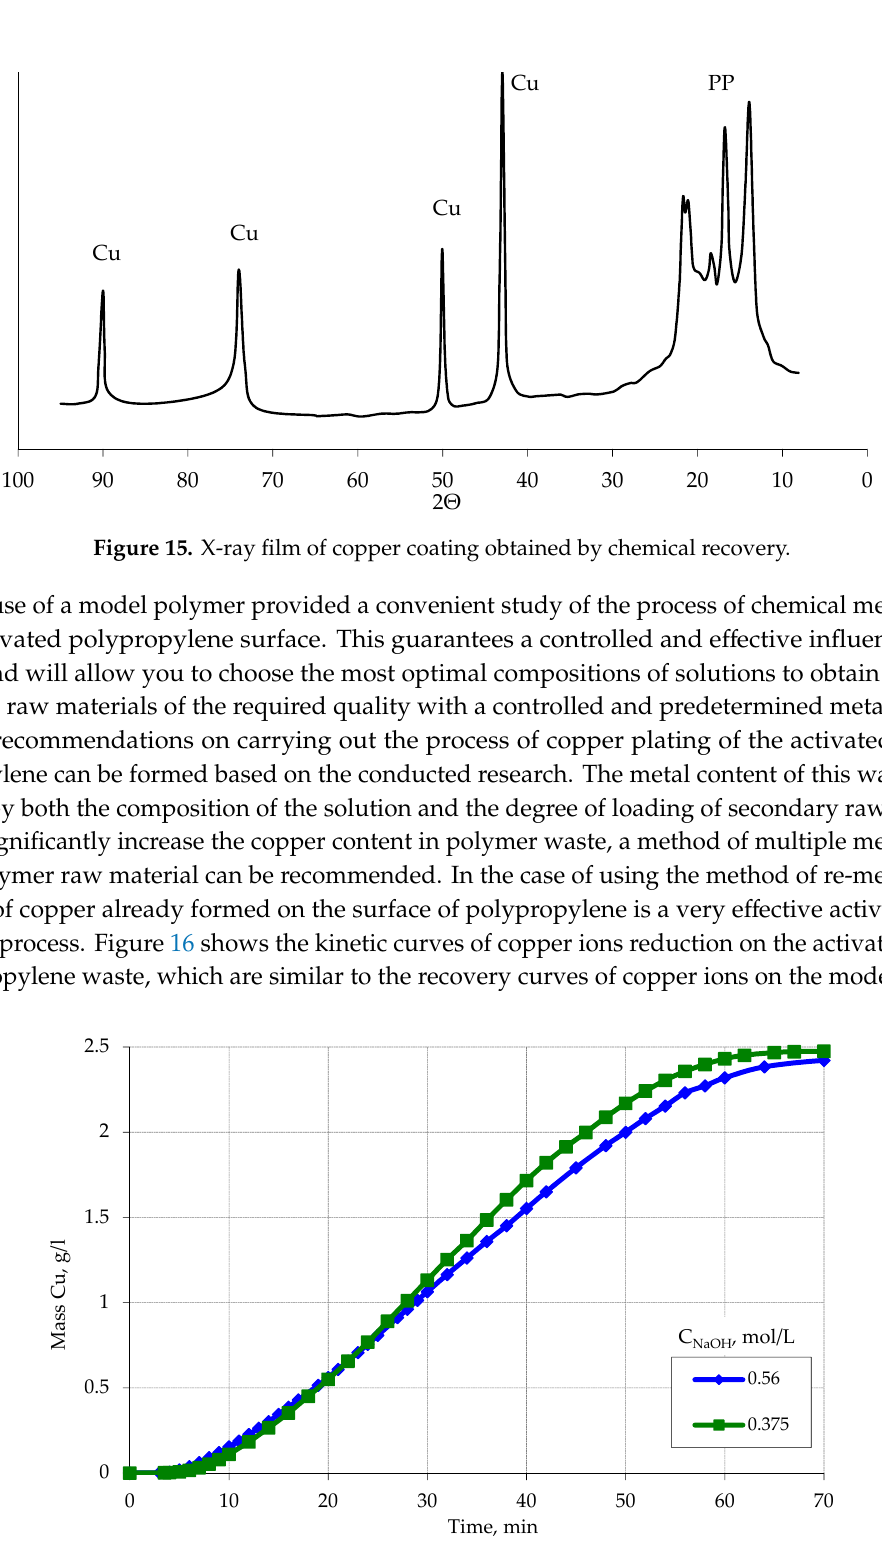
Figure 16. Kinetic curves of copper ion reduction on the activated surface of polypropylene waste.